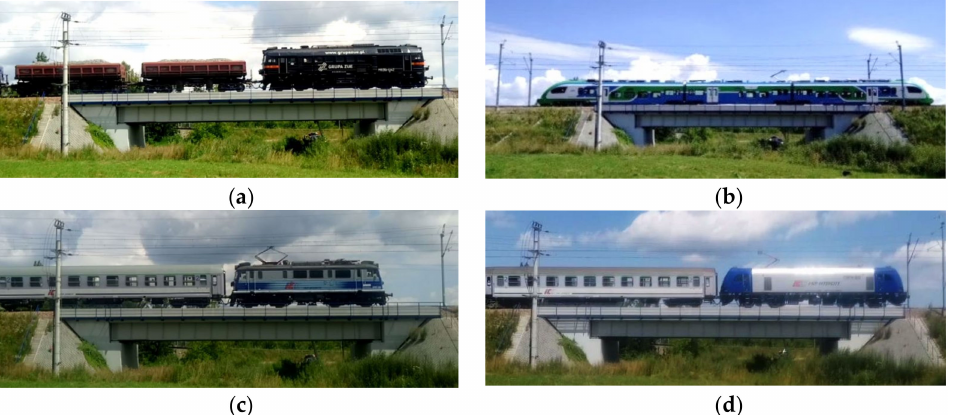
Figure 4. Images of chosen rail vehicles crossing the analyzed bridge: ( a ) cargo train with M62 locomotive, ( b ) railbus—PESA EN62A, ( c ) passenger train with EP-07 locomotive, ( d ) passenger train